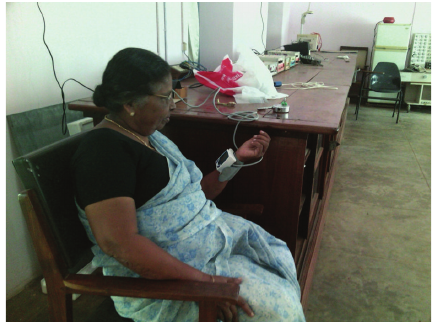
Figure 4: Conduction of testing with wrist device.